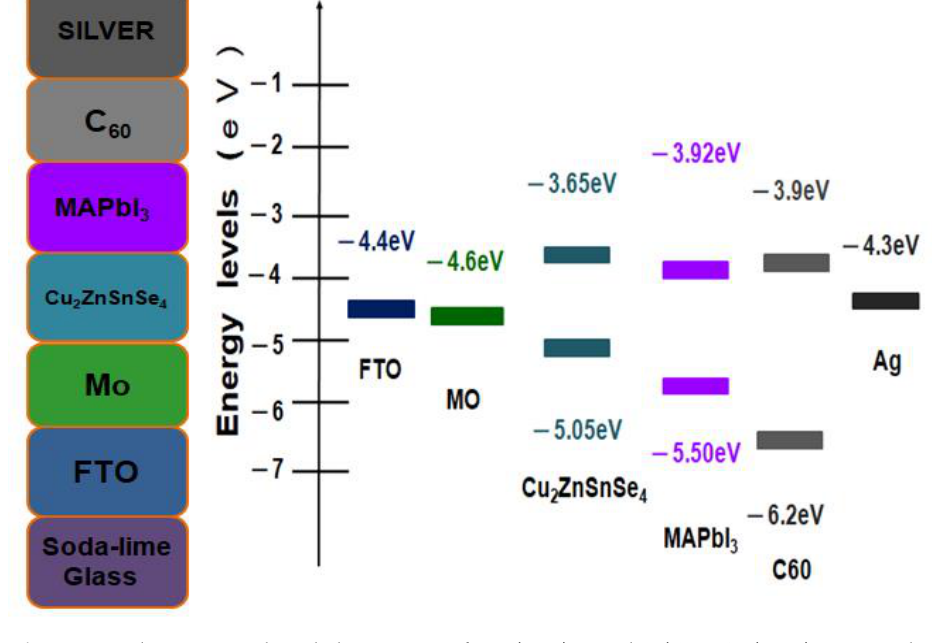
Figure 1. The energy level diagrams of Ag/C 60 /MAPbI 3 /CZTSe/Mo/FTO multilayered thin-film solar cell on glass substrate.